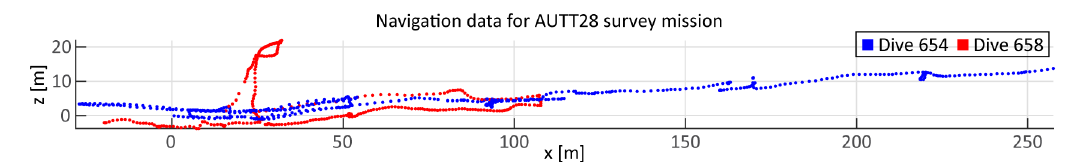
Figure 16. Navigation data for AUTT28 model merged from multiple dives (654-blue;